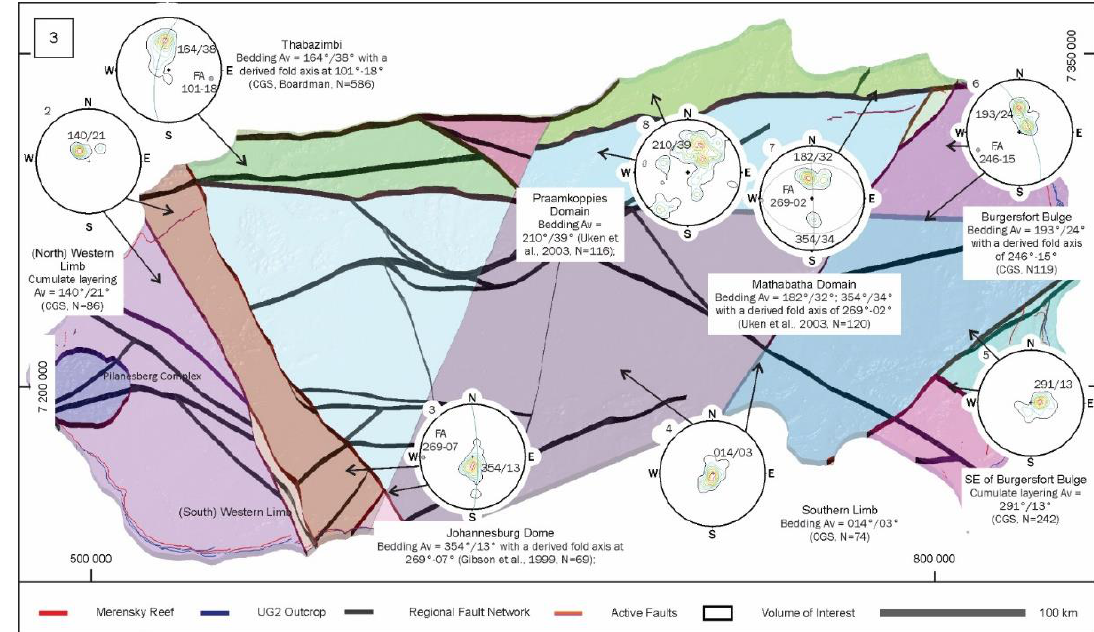
crosscutting relationships. Thirteen regional faults were selected to sub-domain the 3D volume into 23 individual sub-volumes (Figure 3).